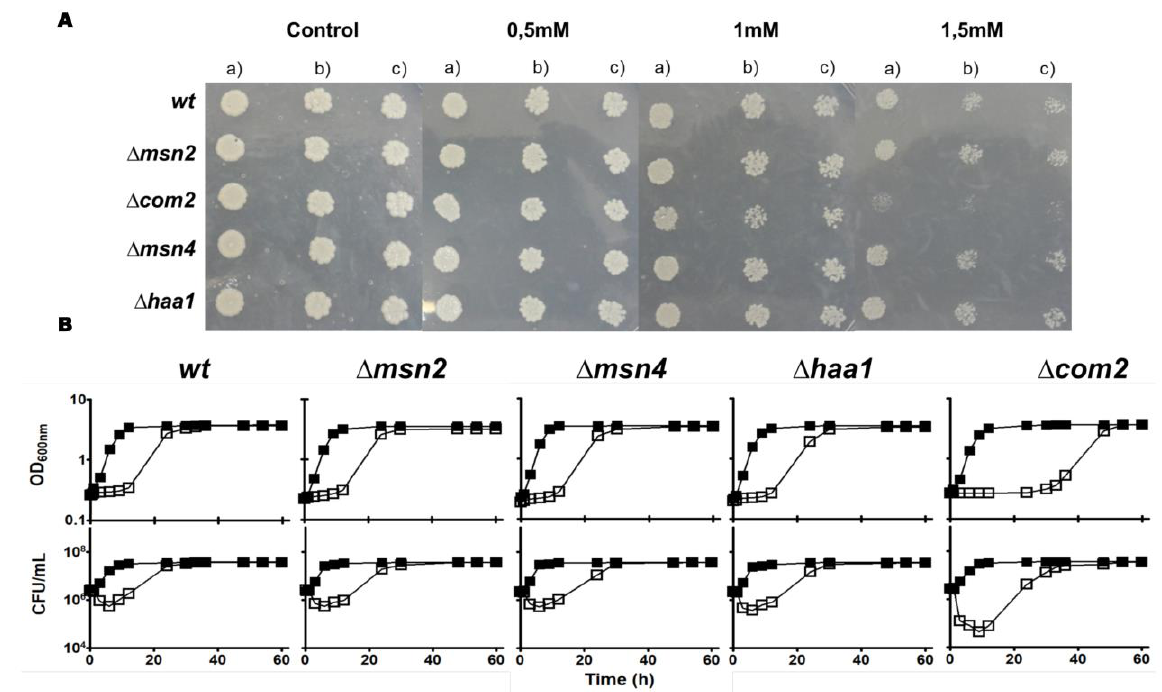
FIGURE 1. Comparison of the susceptibility to SO 2 of the Saccharomyces cerevisiae BY4741 parental strain and the deletion mutants Δ msn2 , Δ msn4 , Δ haa1 and Δc om2 by spot assays (A) or by cultivation in MMB liquid medium (pH 3.5) ( ■ ) or in this medium supplemented with 0.5 mM of SO2 (□) (B) . In (A) the cells used to prepare the spots were grown in MMB liquid medium until mid-exponential phase and then inoculated (at an OD of 0.05) in MMB (pH 3.5) agarized medium supplemented with the indicated concentrations of SO2. Lanes (b) and (c) are, respectively, 1:5 and 1:10 dilutions of the suspension used in lane (a). In (B) growth was followed by measuring culture OD 600 and the concentration of viable cells was assessed as the number of colony forming units per ml of cell culture (CFU ml-1). All the results presented are representative of at least three independent experiments that gave the same pattern of